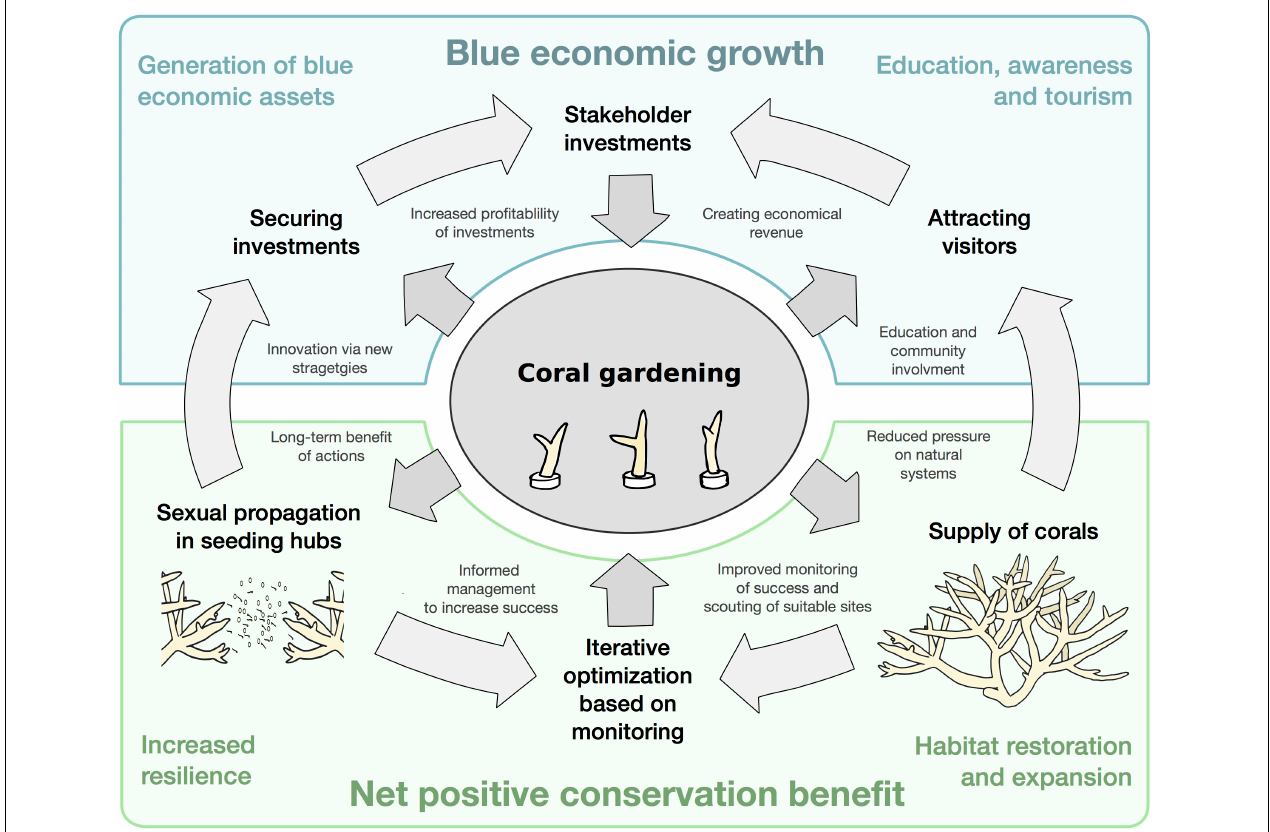
FIGURE 2 | Land-based coral nurseries as an entity to serve toward blue economic growths as well as conservation.